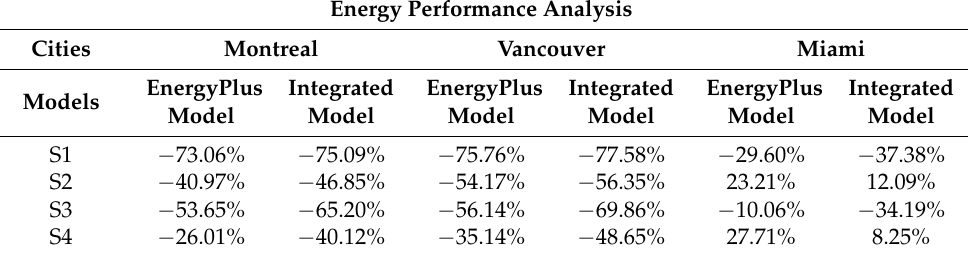
Table 6. Energy performance analysis results by comparison of average percentage difference of simulated hourly space heating/cooling energy consumptions with ASHRAE Standard 90.1 level between EnergyPlus and the integrated model.